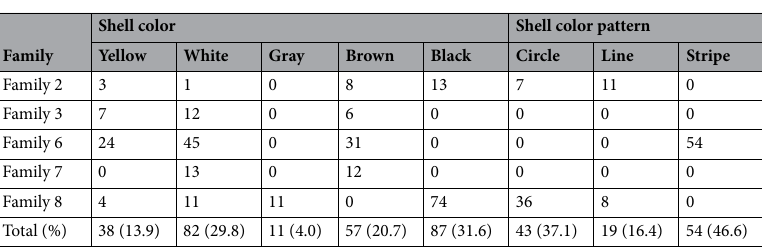
Table 1. Distribution of shell color and pattern phenotypes in the offspring of the five families of C. edule